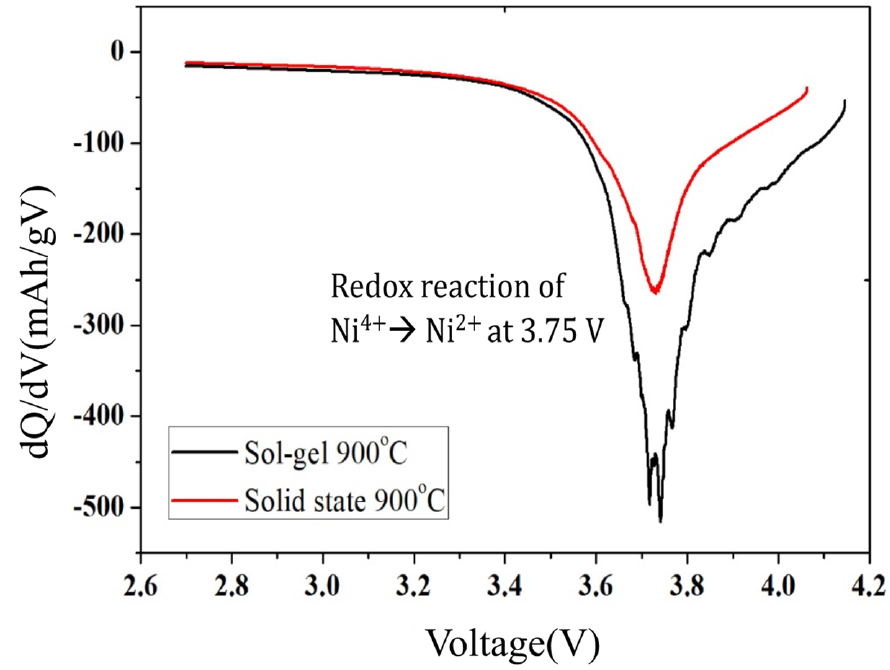
Figure 6. Differential capacity dQ/dV curve at the first cycle of sol-gel and solid-state method sam- ple.